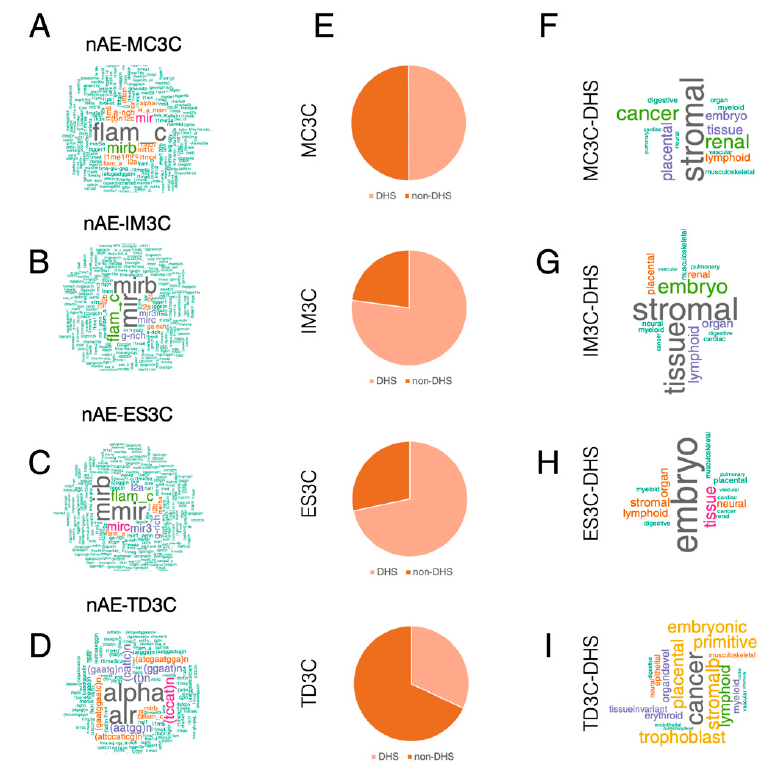
Figure 2. Cell line-specific TFIIIC-bound regions are DHSs linked with phenotypic traits. ( A – D ) Word Cloud analysis of REs associated with non-AE (nAE) MC3C, IM3C, ES3C. Larger fonts stand for higher frequency of the RE. ( E ) Pie charts showing the fraction of MC3C, IM3C, ES3C and TD3C that overlap with DHSs as defined in [36] in light orange and non-overlapping (dark orange). ( F – I ) Word Cloud analysis of disease and phenotypic traits of MC3C, IM3C, ES3C and TD3C that overlap with DHSs (MC3C-DHS, IM3C-DHS, ES3C-DHS and TD3C-DHS) as defined in [36]. Larger fonts stand for higher frequency of the disease and phenotypic traits found in the